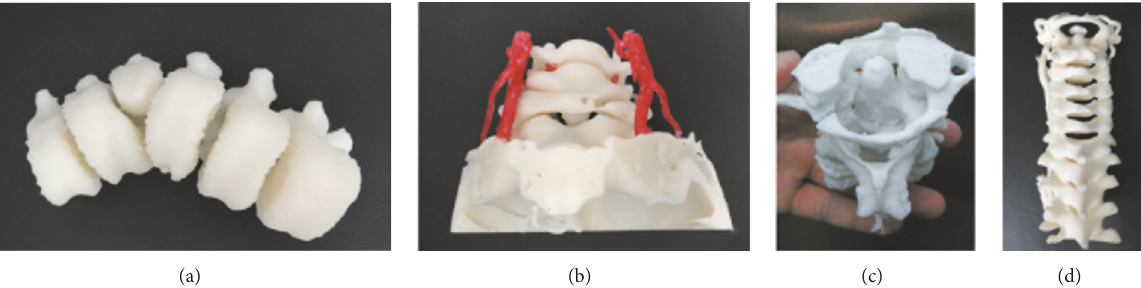
Figure 2: (a) Scoliosis. (b) Atlas neoplasm. (c) and (d) Cervical fracture-dislocation (source: reproduced and adapted with permission from Wang et